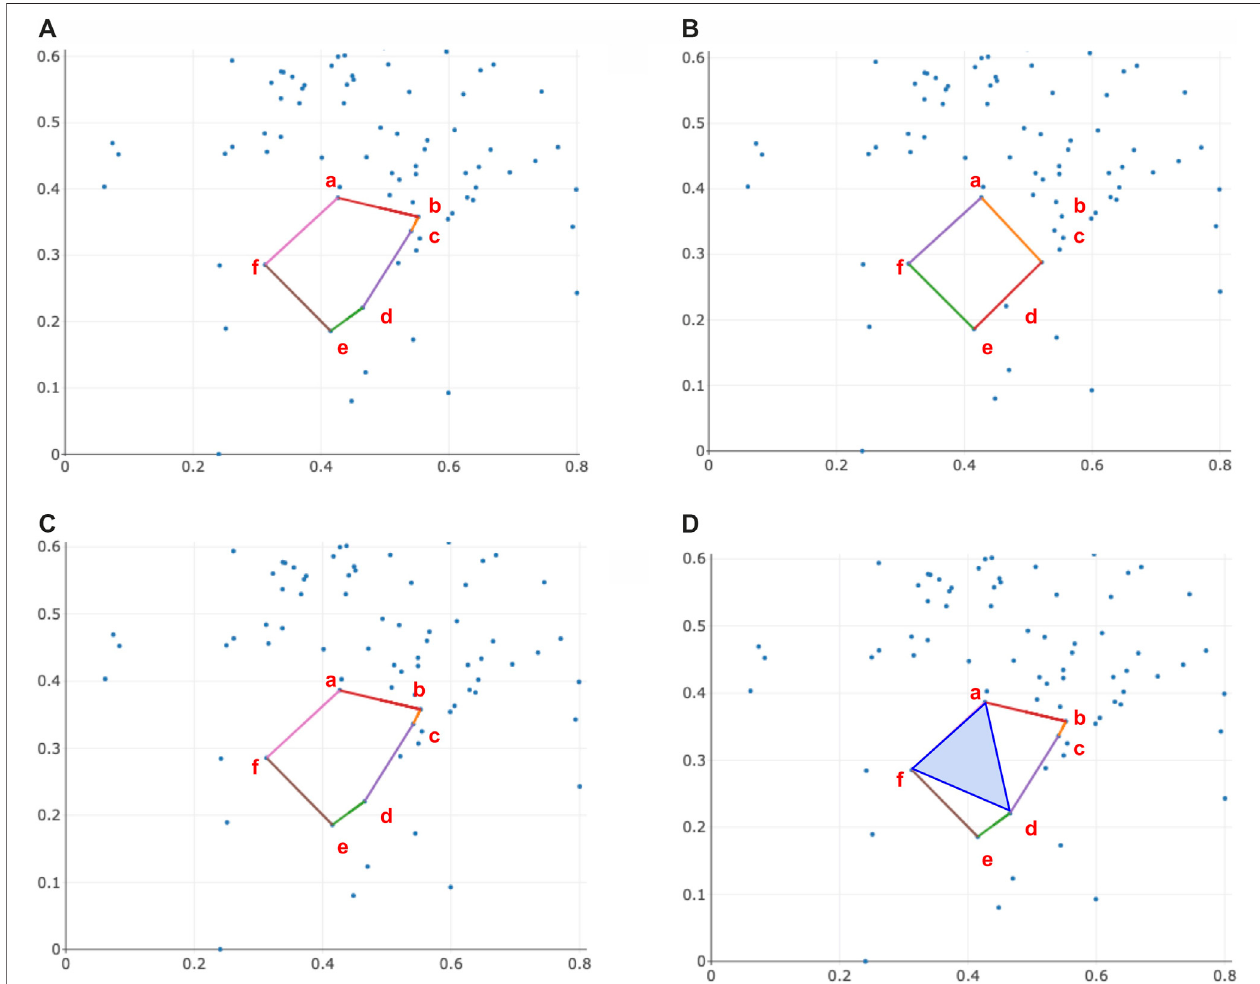
FIGURE9| Anexampleillustratingwhentheareaenclosedbythetriangle-lossarea-weightedoptimalcycle,solutiontoProgramTri NI Area ,canbelargerthanthearea enclosed by the edge-loss length-weighted minimal cycle, solution to Program Edge NI Len (A) is the original cycle of a representative point cloud in R 2 drawn from the normal distribution (B) is the length-weighted edge-loss optimal cycle (C) is the area-weighted triangle-loss optimal cycle, in this example, it is the same cycle as the original cycle (D) is the area-weighted minimal cycle where the blue shaded area marks the triangle born at the death time of the cycle. Constraint Eq. 9 speci fi es thatthearea-weightedoptimalcyclemustcontainthe2-simplexbornatthedeathtimeofthecycle.Therefore,thiscyclemustcontain ( a , d , f ) becauseitwasbornatthe death time. The length-weighted minimal cycle does not have this constraint, and as such, can result in a smaller